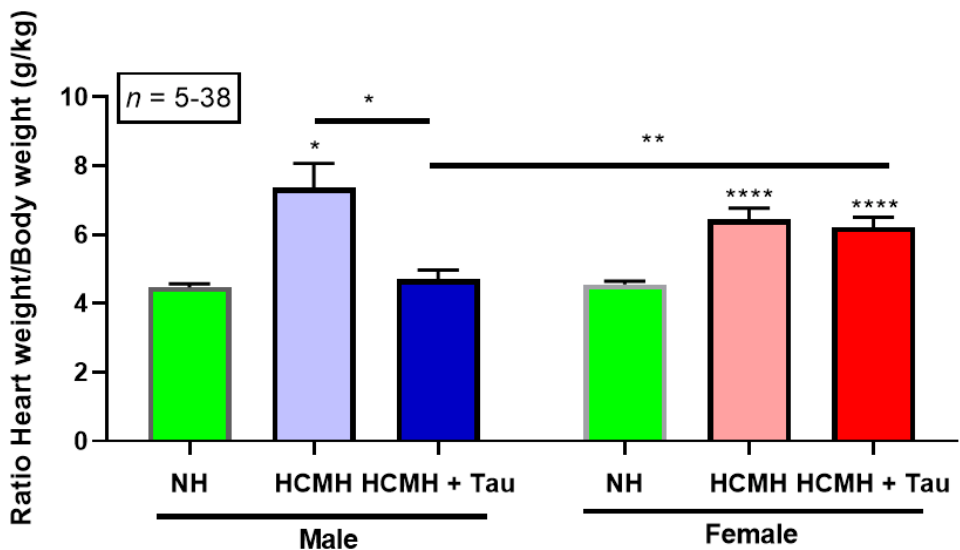
Figure 1. Effect of a 20-day treatment of males and females HCMHs with taurine on the heart weight/body weight ratio. Results are expressed as mean ± S.E.M. Comparisons are between untreated HCMHs and taurine-treated HCMHs. * p < 0.05, ** p < 0.001 and **** p < 0.0001. NH = normal hamster; HCMH = hereditary cardiomyopathic hamsters; Tau = taurine; S.E.M. = standard error of the mean; n = number of animals.